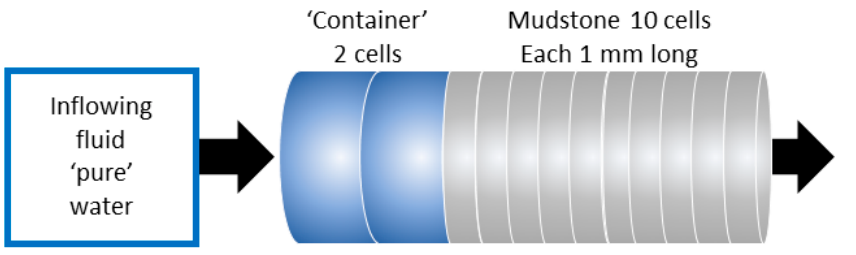
Figure 3. Geometry of the experimental set-up as represented in CABARET. ‘Container’ represents the fluid reservoir, with the mudstone divided into 10 sections, each 1 mm long and 20 mm in diameter (note: not to scale).